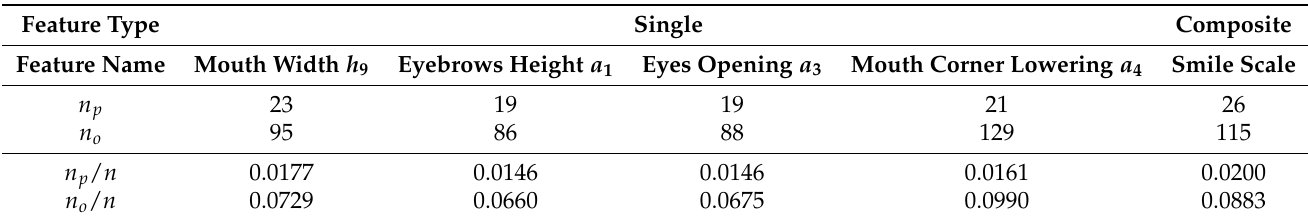
Table 7. Various parameters and ratios measured (Subject B: number of whole data n = 1303).